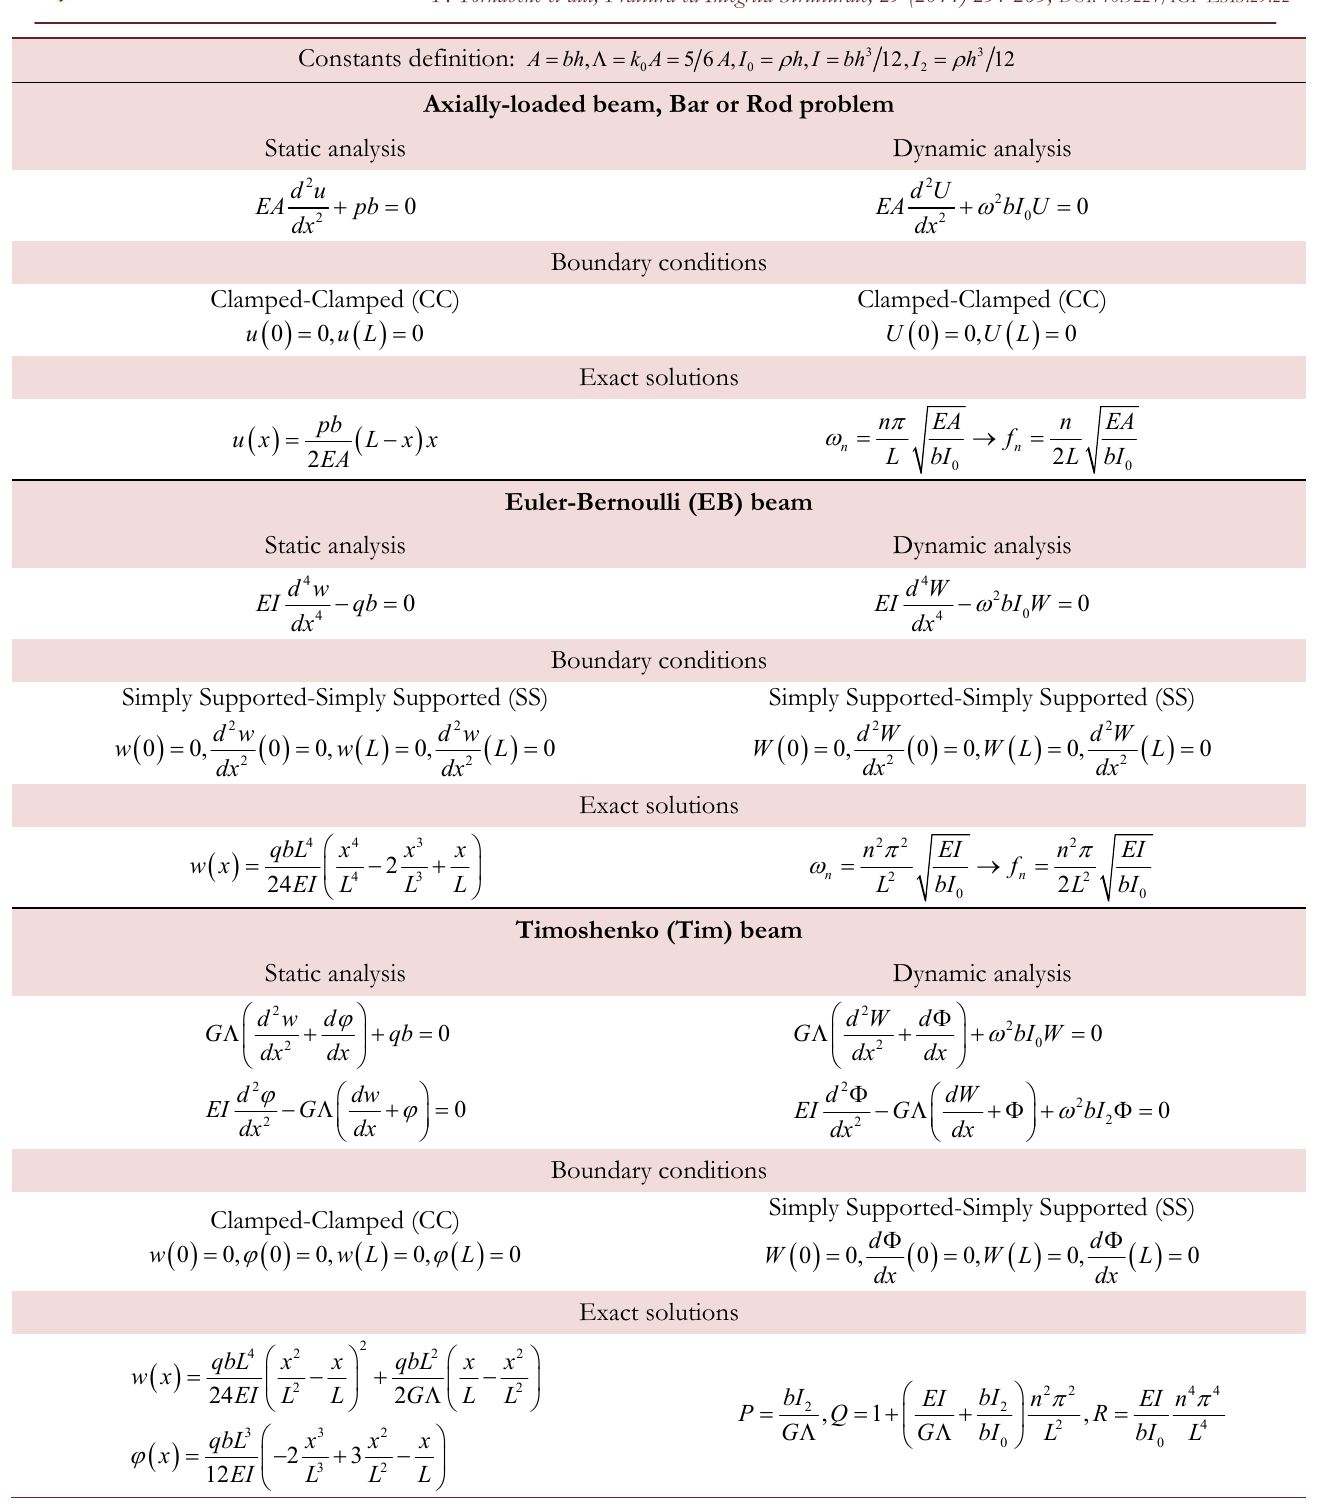
Table 3: List of one dimensional static and dynamic exact